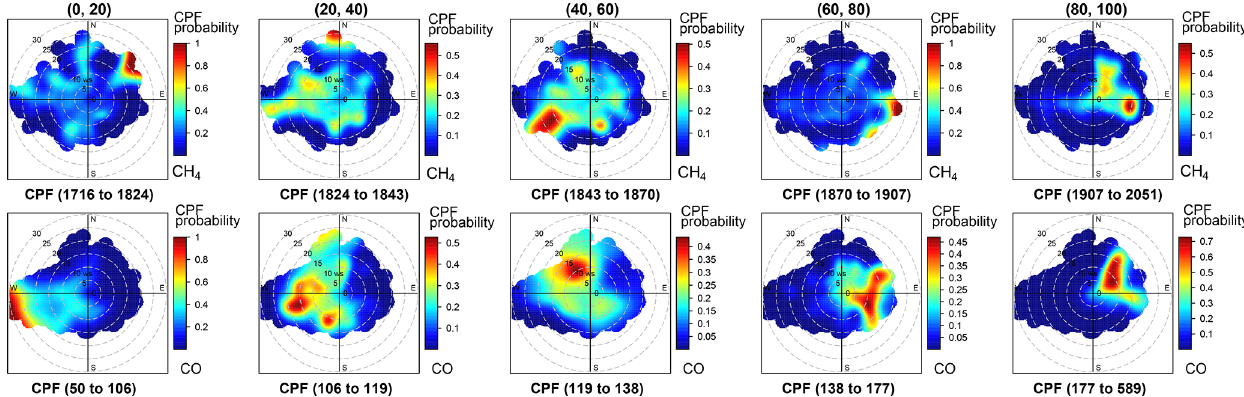
Figure 5. The polar plot of the distribution of the CH 4 and CO concentration probabilities in different percentile ranges at the WLG station. The analysis was based on the conditional probability functions (CPFs) by Ashbaugh et al. (1985). The top row shows the analysis of CH 4 from 1994 to 2019. The bottom row shows the CO measurements in 2004–2019. Note: ws – wind speed. The values at the bottom of each panel show the range of concentrations in the relevant percentile range. Gradient colors represent the levels of CPF probability in different percentile ranges.